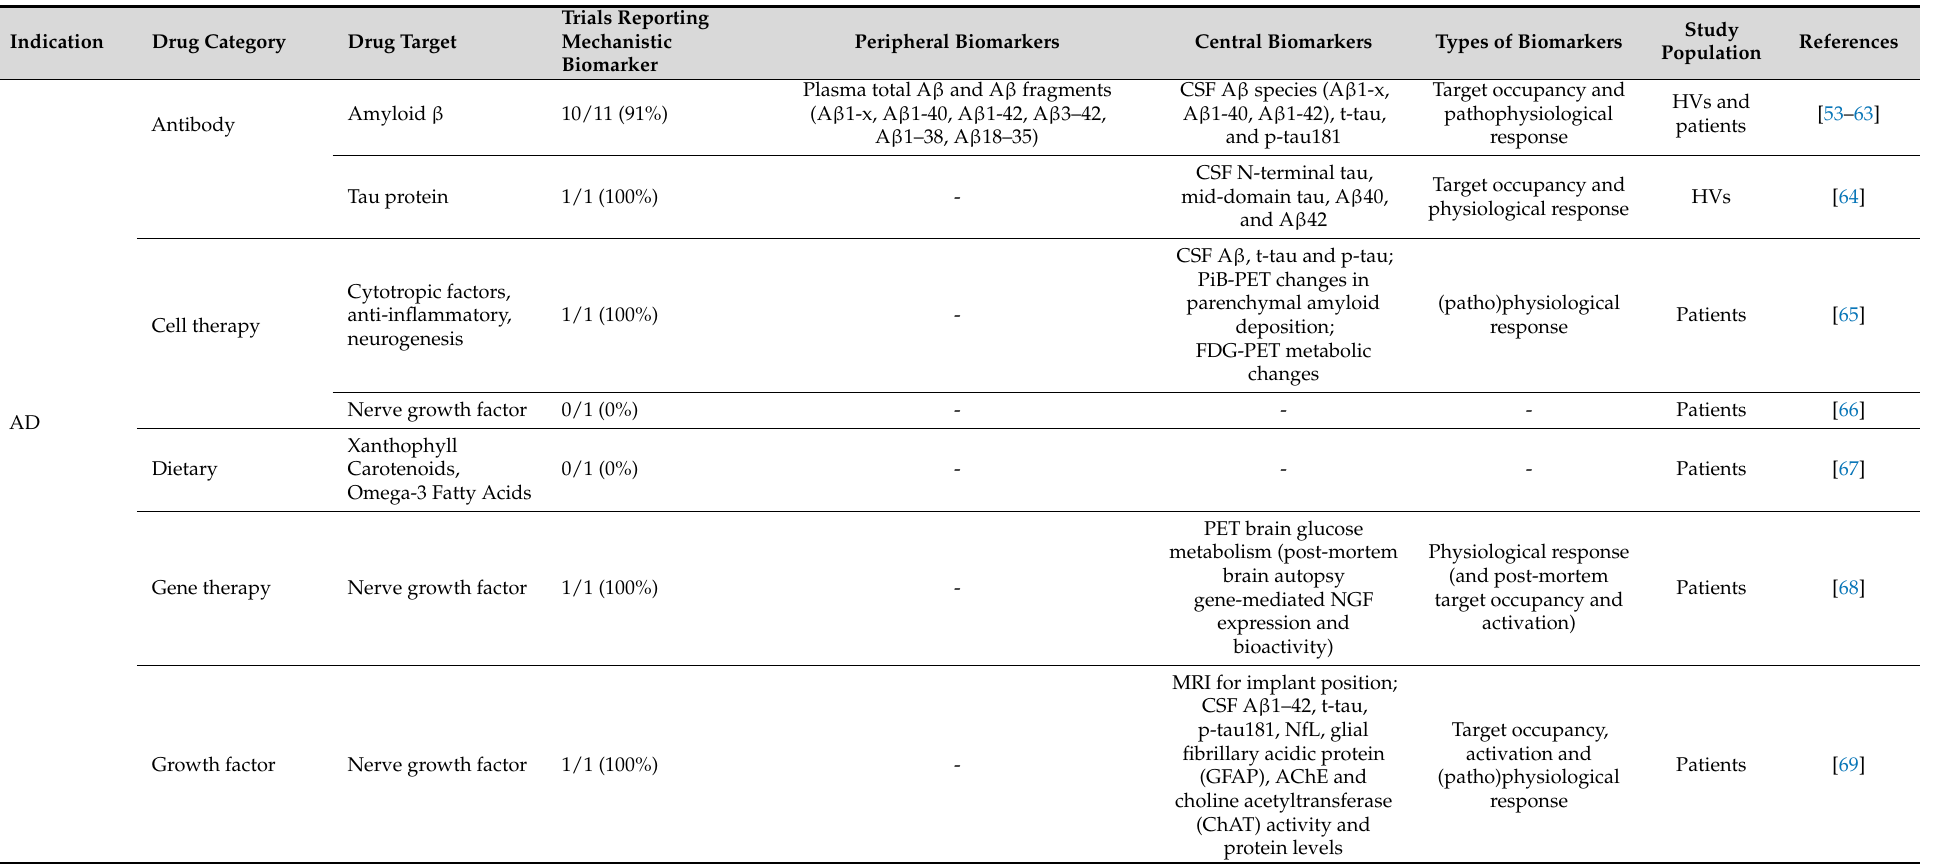
Table 2. Overview of published early phase clinical trials for disease-modifying compounds in neurodegenerative disorders between 2010 and November 2020 and reported peripheral and central pharmacodynamic biomarker